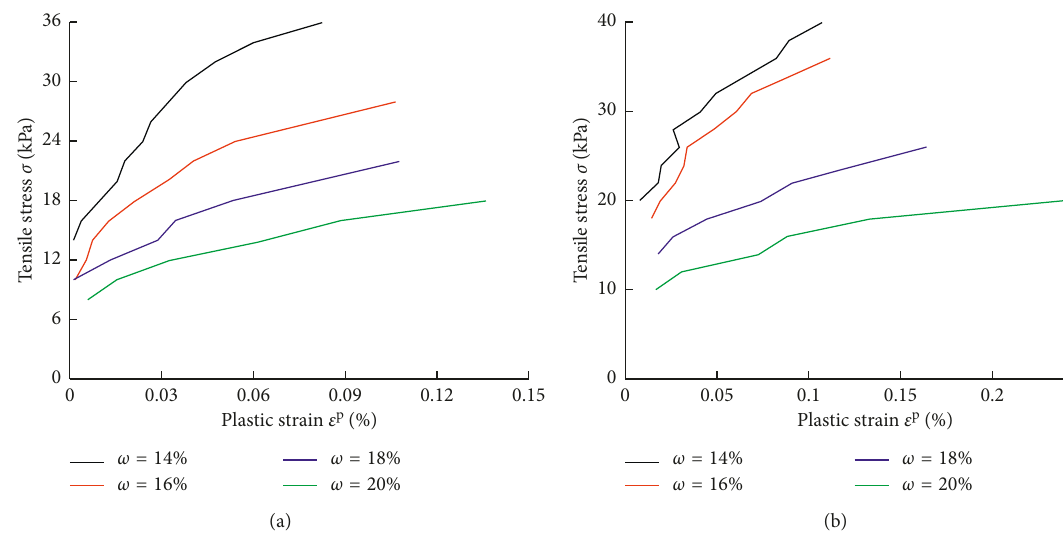
Figure 7: Plastic constitutive relation σ � φ ( ε p ) with (a) ρ